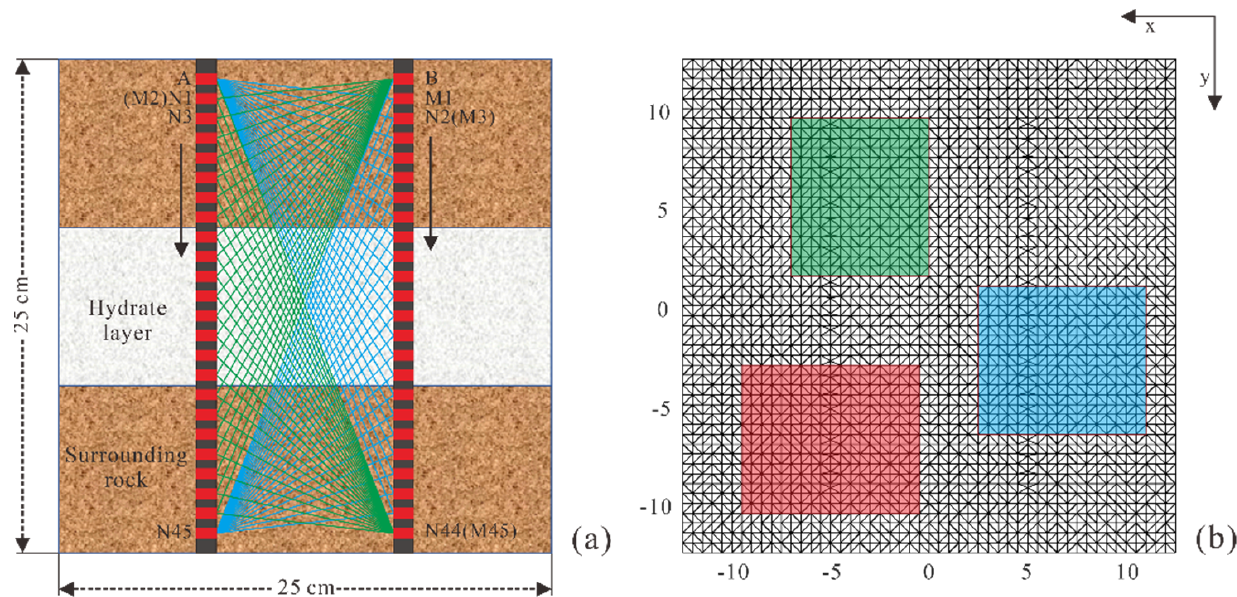
Figure 1. Model of ERT and its mesh. ( a ) The physical simulation model of ERT, where the red rectangles represent electrodes. A and B are current injection electrodes, and M and N are voltage measurement electrodes; ( b ) the forward and inverse problem mesh, where different colored grids represent different resistivity values.